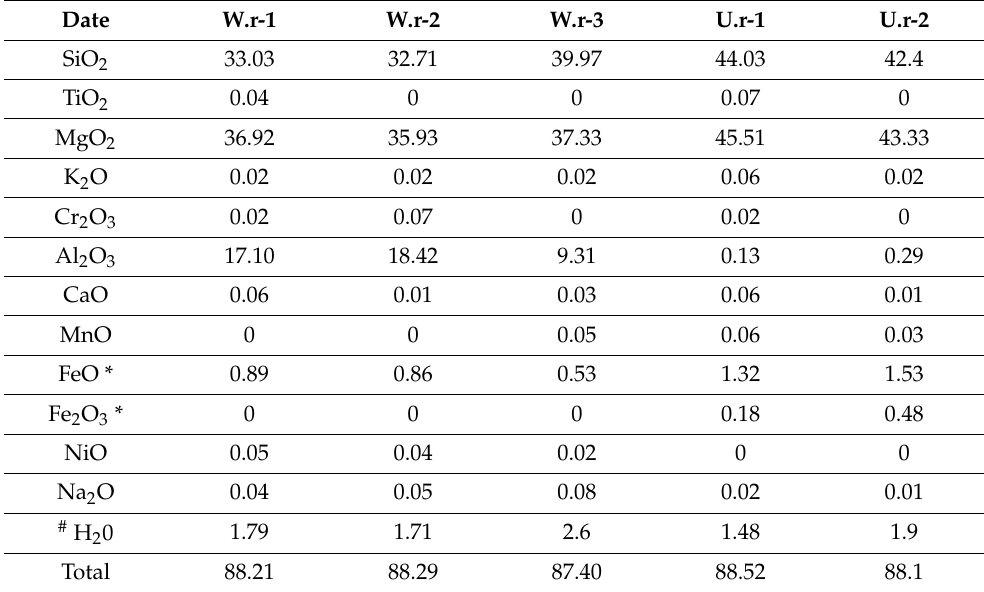
Table 3. The EPMA data of the weathering rind and unweathered core samples